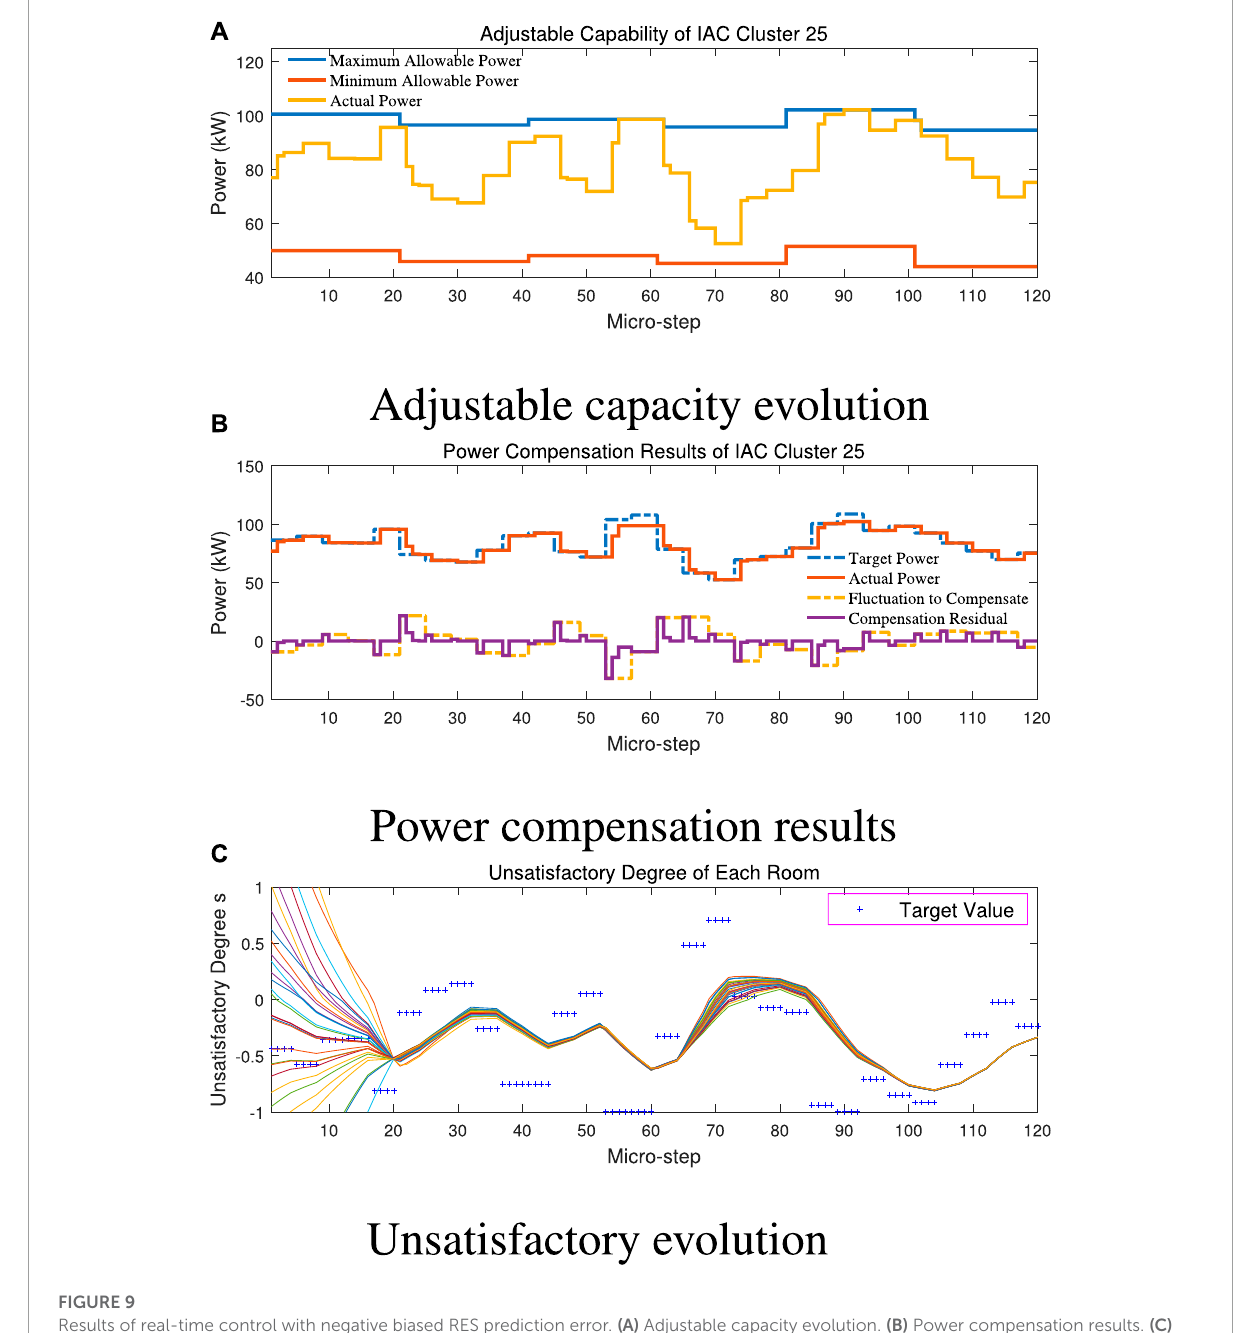
FIGURE 9 Results of real-time control with negative biased RES prediction error. (A) Adjustable capacity evolution. (B) Power compensation results. (C) Unsatisfactory evolution.